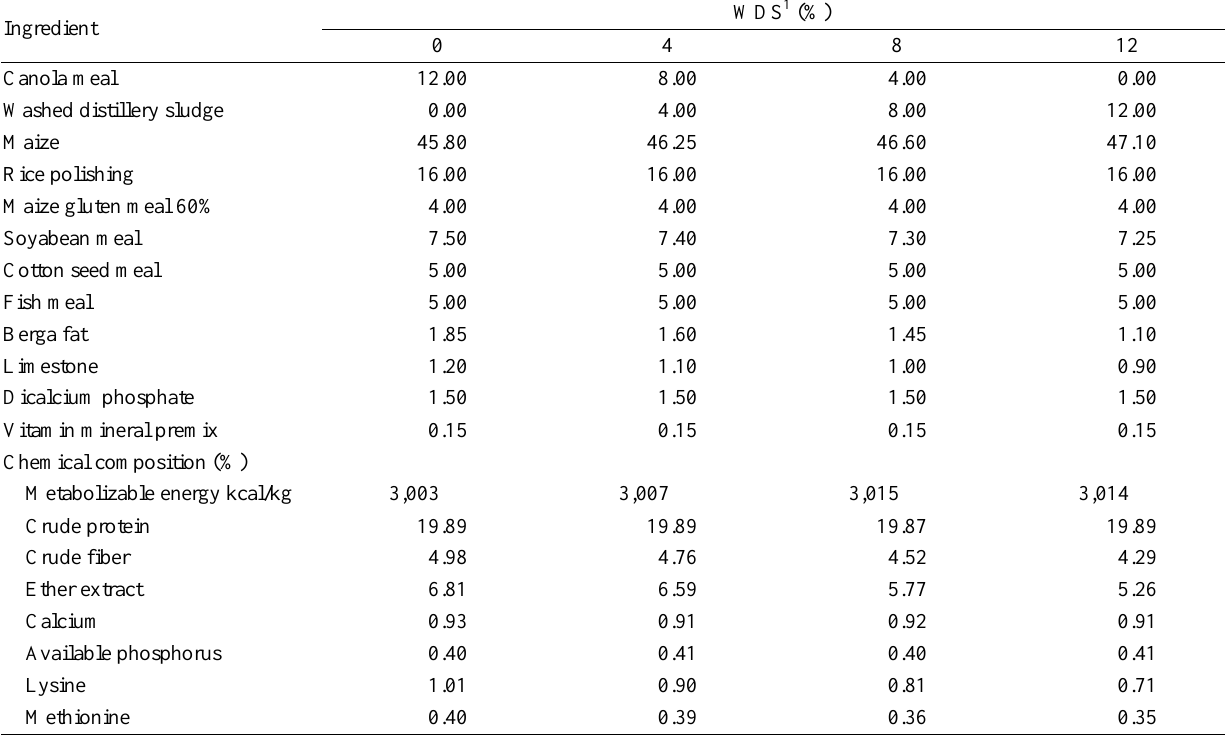
Table 4. Percent ingredients and nutrient composition of broiler finisher diets (5-6